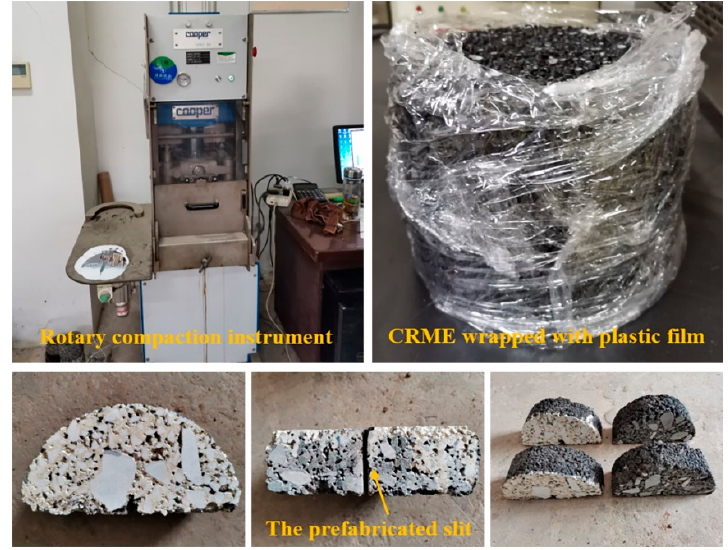
Figure 3. The preparation process of CRME samples.